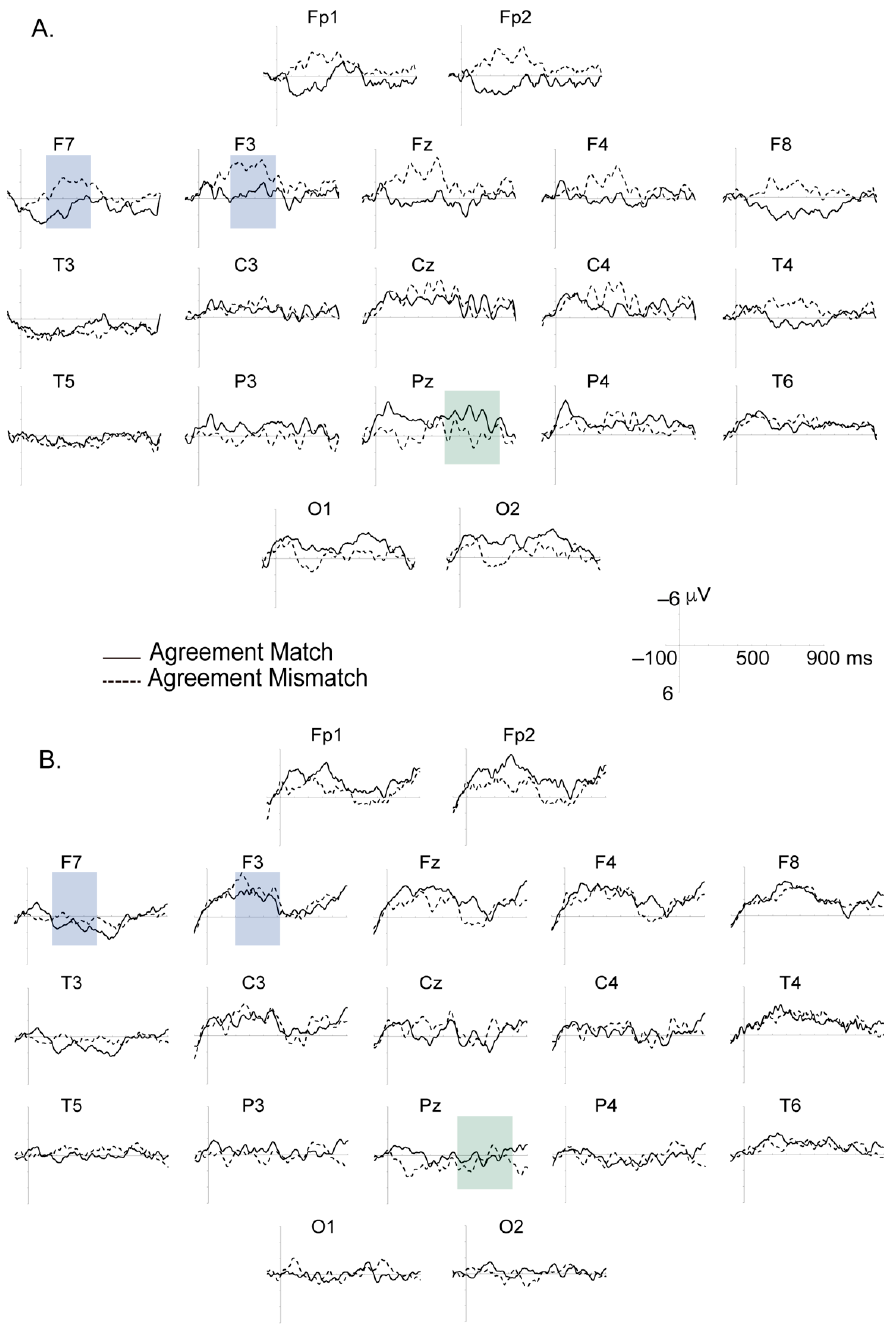
Figure 2. Grand average ERPs of ( A ), the TD children and ( B ), the children with DLD. The gender-mismatch of the clitic in the sentence/picture pair condition (dotted line) is plotted against the gender-match condition (solid line). The axis of the ordinates indicates the onset of the clitic. Negative voltage is plotted up. Purple and green shadow boxes show the time windows analyzed.